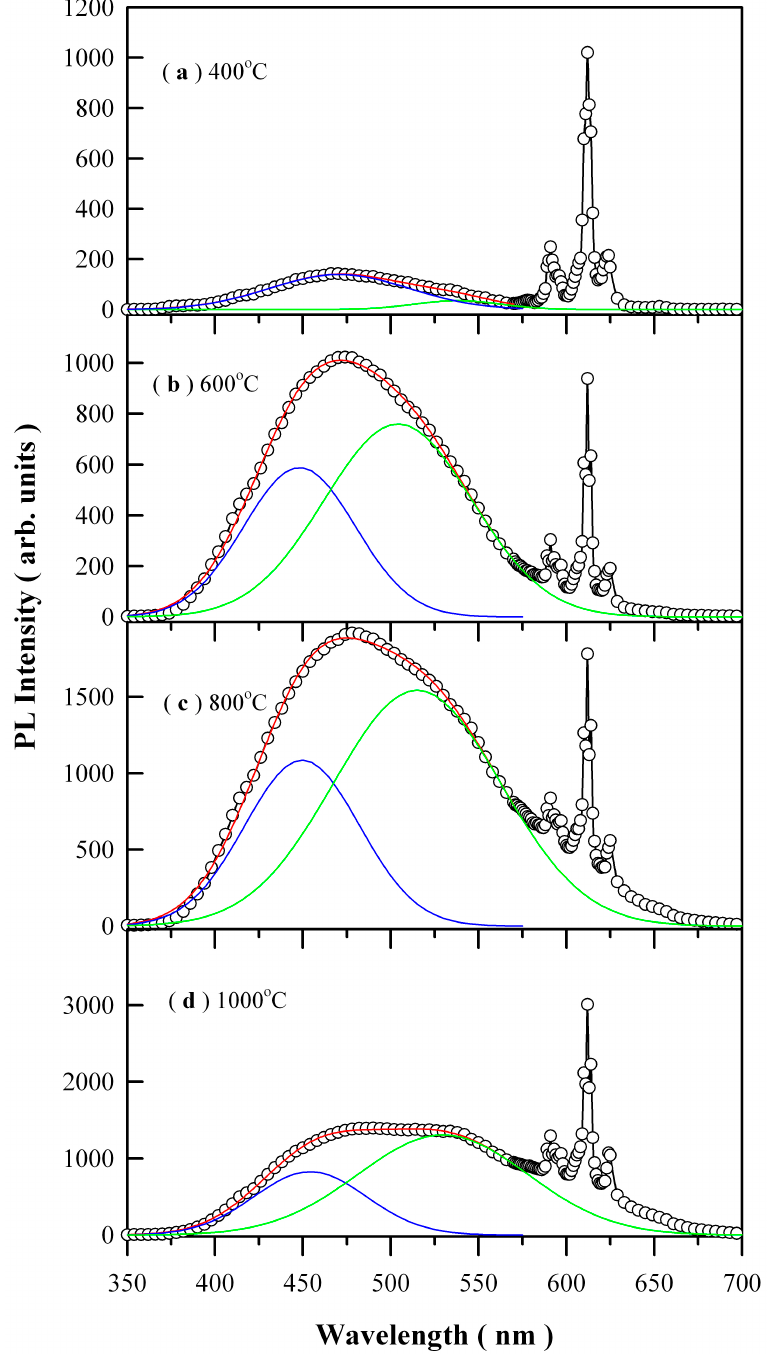
Figure 8. PL spectra of Eu-doped ZnWO 4 precursors subjected to annealing at different temperatures: ( a ) 400 °C; ( b ) 600 °C; ( c ) 800 °C; and ( d ) 1000 °C. The blue curve and the green curve stand for the blue and green components of Gaussian decomposition, respectively. The red curve is the sum of the two components. The excitation wavelength was 325 nm.